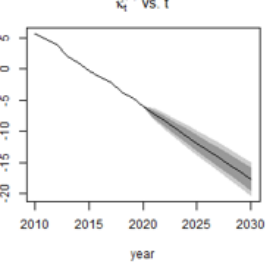
Figure 12. Parameter Forecast using the Lee–Carter Model.